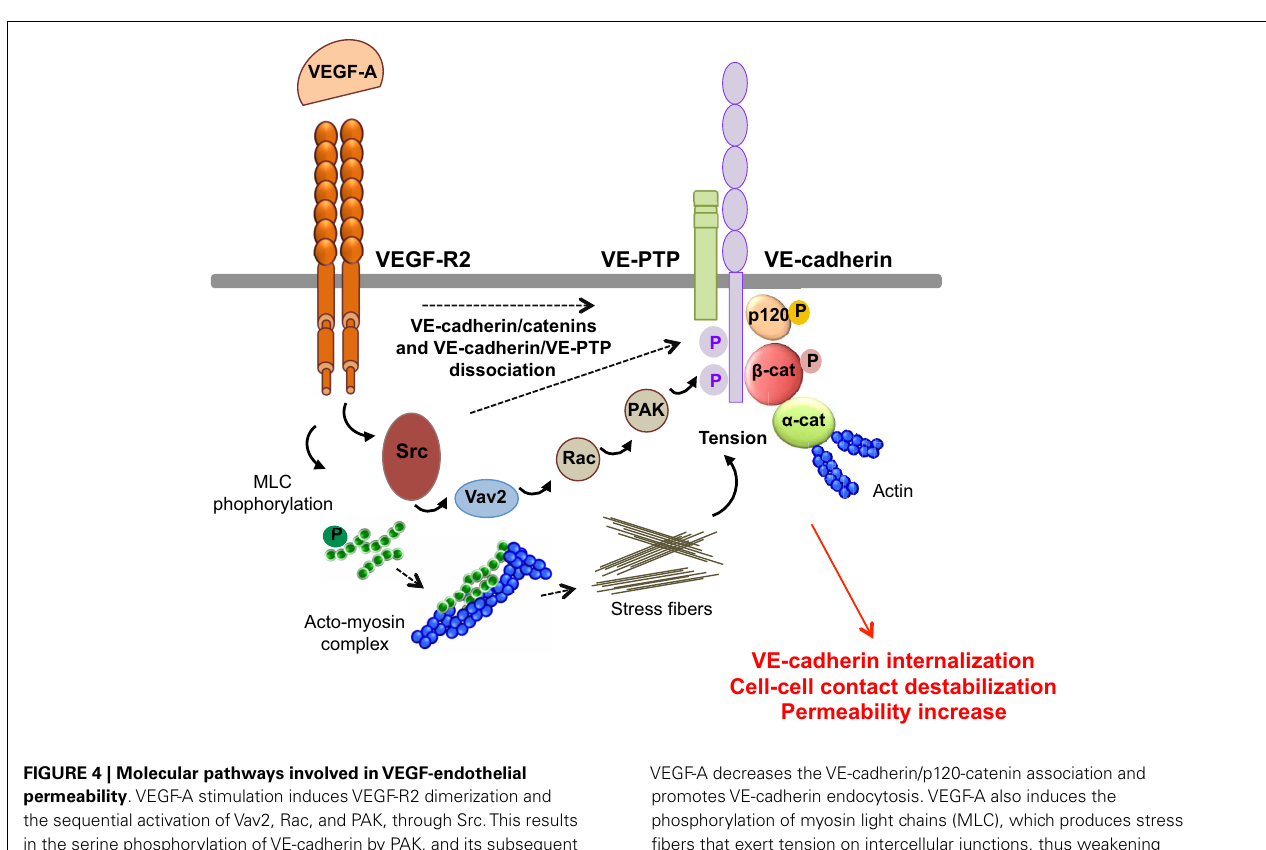
FIGURE 4 | Molecular pathways involved inVEGF-endothelial permeability .VEGF-A stimulation inducesVEGF-R2 dimerization and the sequential activation ofVav2, Rac, and PAK, through Src.This results in the serine phosphorylation ofVE-cadherin by PAK, and its subsequent internalization into clathrin-coated pits.VEGF can also trigger the tyrosine phosphorylation ofVE-cadherin and of its binding partners β -catenin ( β -cat) and p120, in a Src-dependent fashion. In addition,